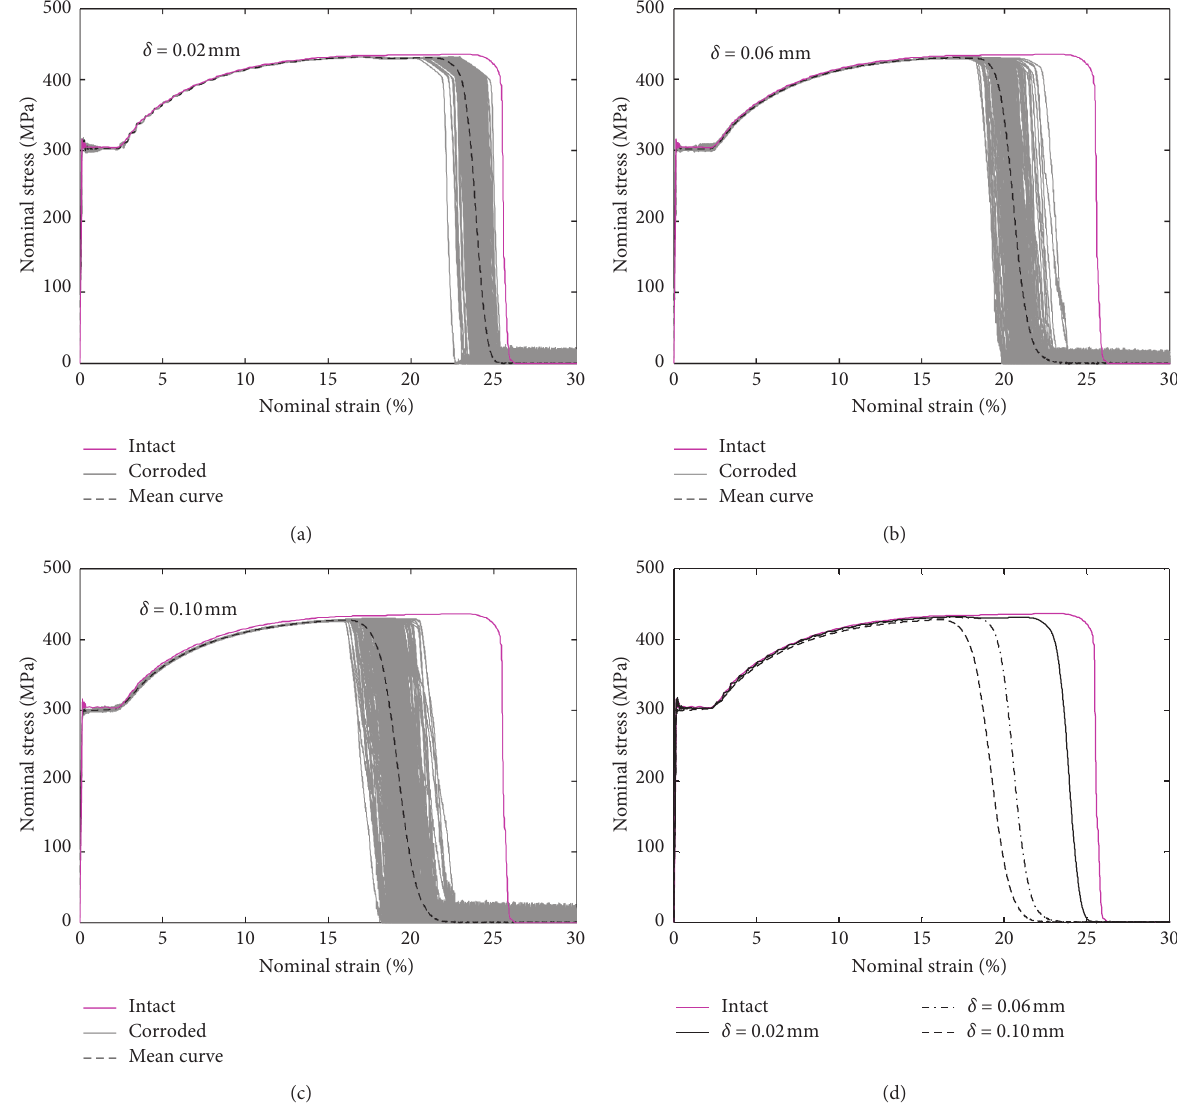
Figure 15: Stress-strain curves predicted using MCS with 300 samples ( η �